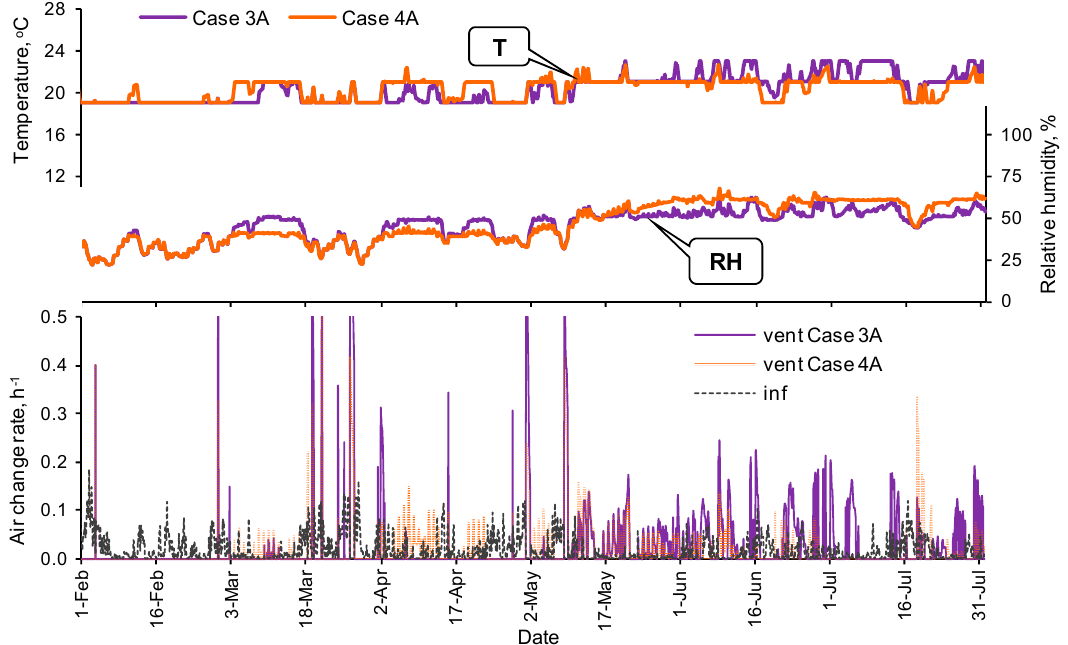
Figure 7. Variation in the indoor relative humidity, temperature, and ventilation airflow in the ethnography hall for cases with additional ventilation over a period of February to July.